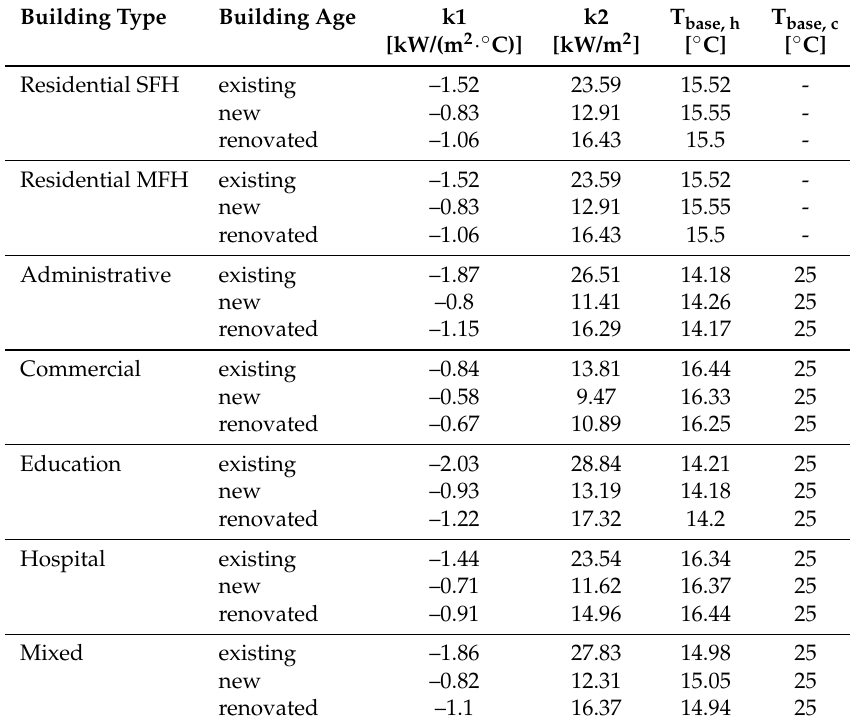
Table A25. Heat signature coefficients for all building types and